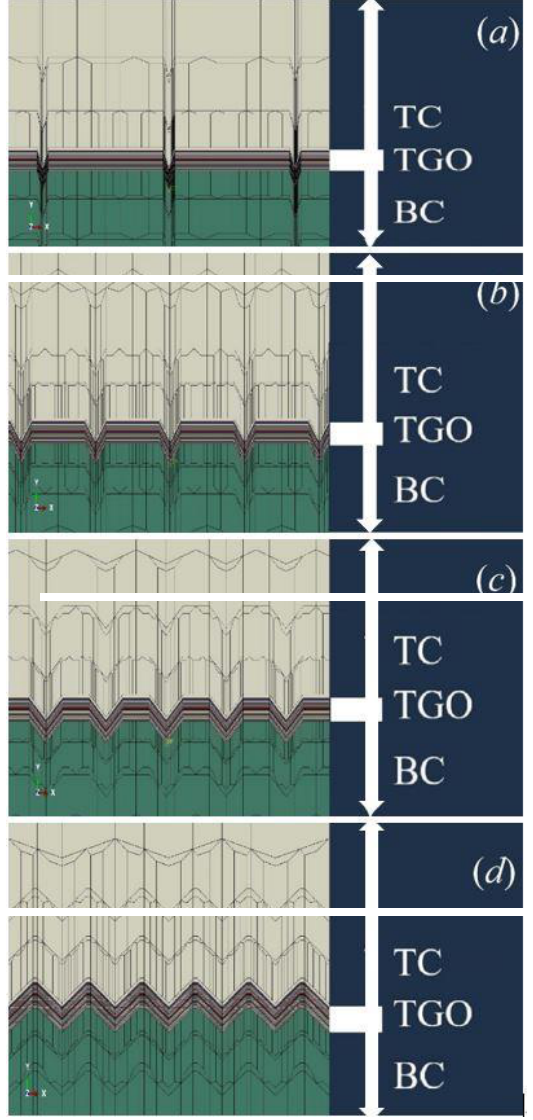
Figure 33. Interfacial roughness profile for different spacing between imperfections. where the interfacial roughness profile ( a – d ) are characterzied by prameters provided in Table 4.